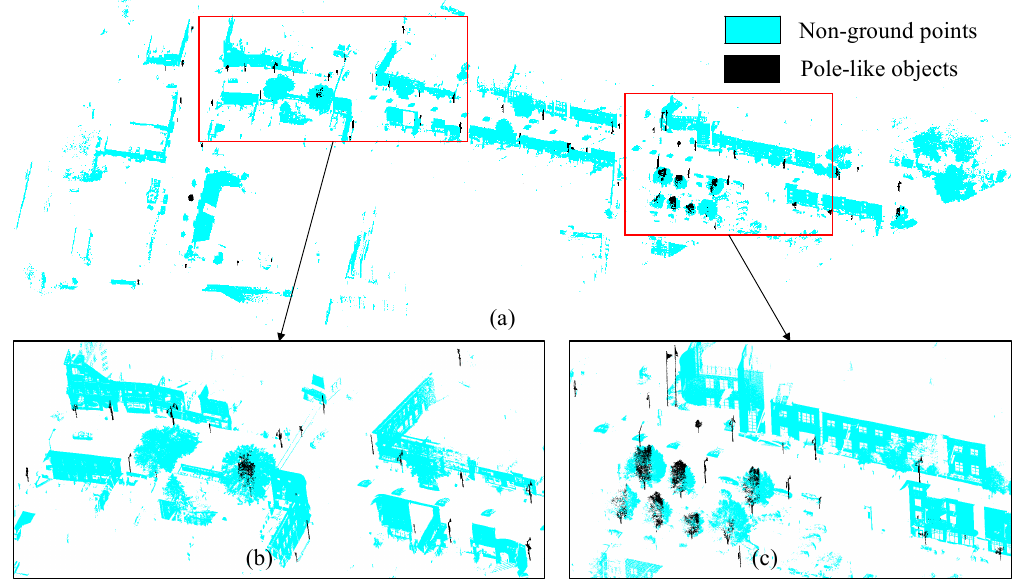
Figure 10. Results of PLOs extraction in Data II. ( a ) Non-ground points colored in cyan and PLOs colored in black; ( b ) view 1; ( c ) view 2.